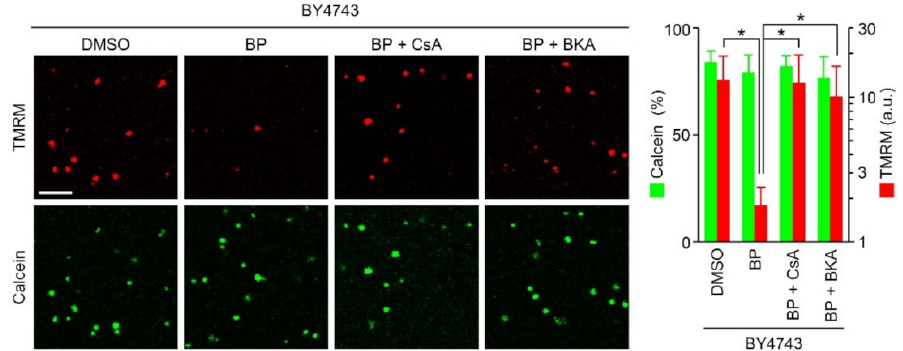
Figure 5. BP opens the CsA- and bongkrekate-sensitive low conductance channel in isolated yeast mitochondria, as indicated by the release of TMRM but not calcein. Isolated mitochondria from BY4743, preloaded with calcein (green) and labeled with TMRM (red), were energized at 25 ◦ C with 5 mM succinate and treated with 5 µ M BP in the presence or absence of 3 µ M CsA or 10 µ M bongkrekate. Representative confocal images at 10 min after BP treatment and quantification of TMRM signals (data represent the mean ± SD from 200 mitochondria; * p < 0.001). Scale bar: 5 µ